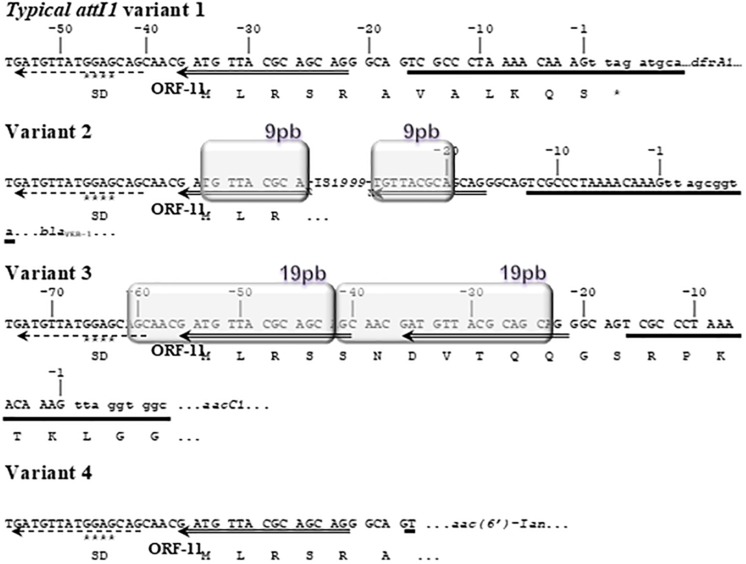
Comparison of the attI1 recombination sites found in the GI of A144, A155 and AYE. The variant 1 is the typical attI1 site. Variant 2 shows the insertion of the IS1999 and a 9 bp duplication of a portion of the attI1 site. Variant 3 found in the three genomes, shows a 19 bp duplication. Variant 4 has a deletion of the 3′ end of the attI1 site. The characteristic regions of the attI1 site are marked as follows: Direct Repeat 2 (DR2), broken-line arrow; Direct Repeat 1 (DR1), double-line arrow; simple site, horizontal line; Shine-Dalgarno (SD) sequence identified for the orf-11, stars. The predicted sequence of the orf-11 is shown. The duplications are depicted in boxes. The gene cassette next to each attI1 variant is indicated and the corresponding initial nucleotides are shown in lower case. The sequences of the variants 1 to 4 of the attI1 site found in AYE correspond to the following coordinates in CU459141.1: 3.677.401-3.677.465 bp, 3.661.663-3.663.064 bp, 3.624.336-3.624.419 bp and 3.668.061-3.68.101 bp, respectively.